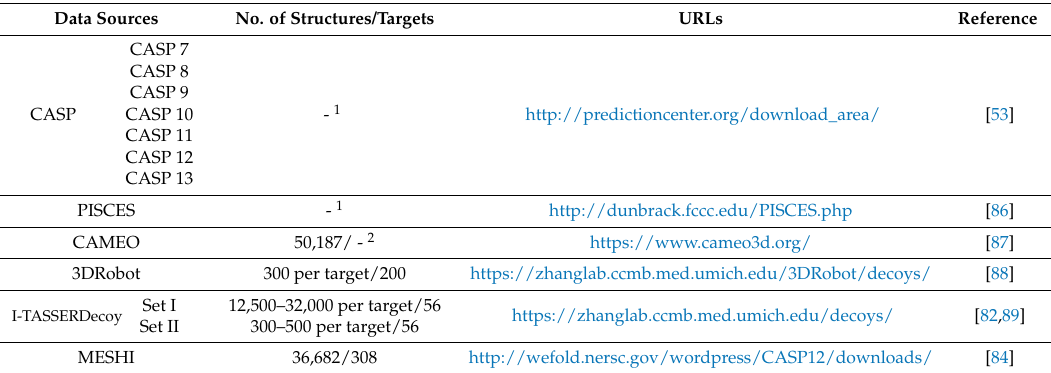
Table 3. Several commonly used data sources for training and testing EMA